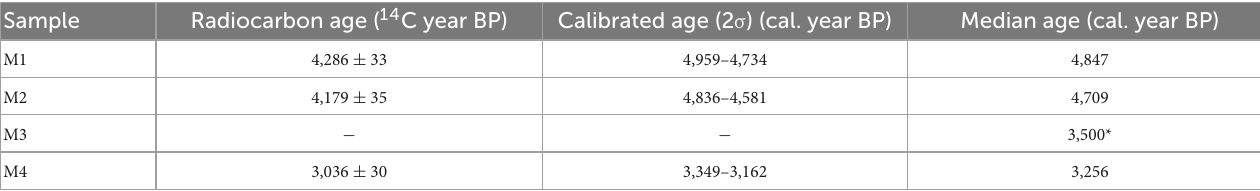
TABLE 3 Radiocarbon ages from terrestrial plant macrofossils from the A294 ice cave.